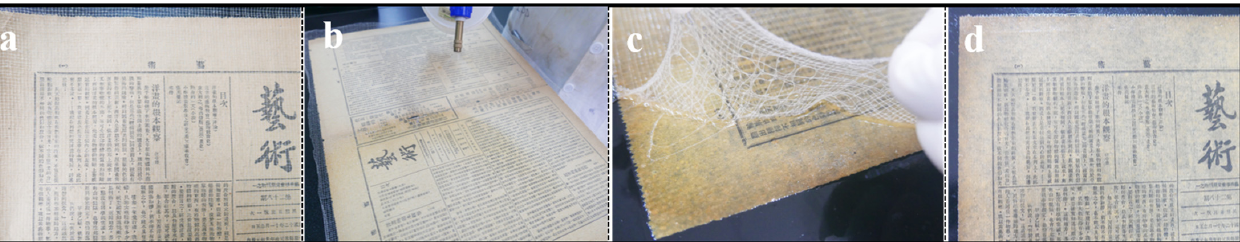
Figure 3. Test results of the mechanical properties of simulated samples before and after aging and restoration were as follows: folding endurance ( a ); tensile strength ( b ); tearing strength ( c ); bursting strength ( d ).